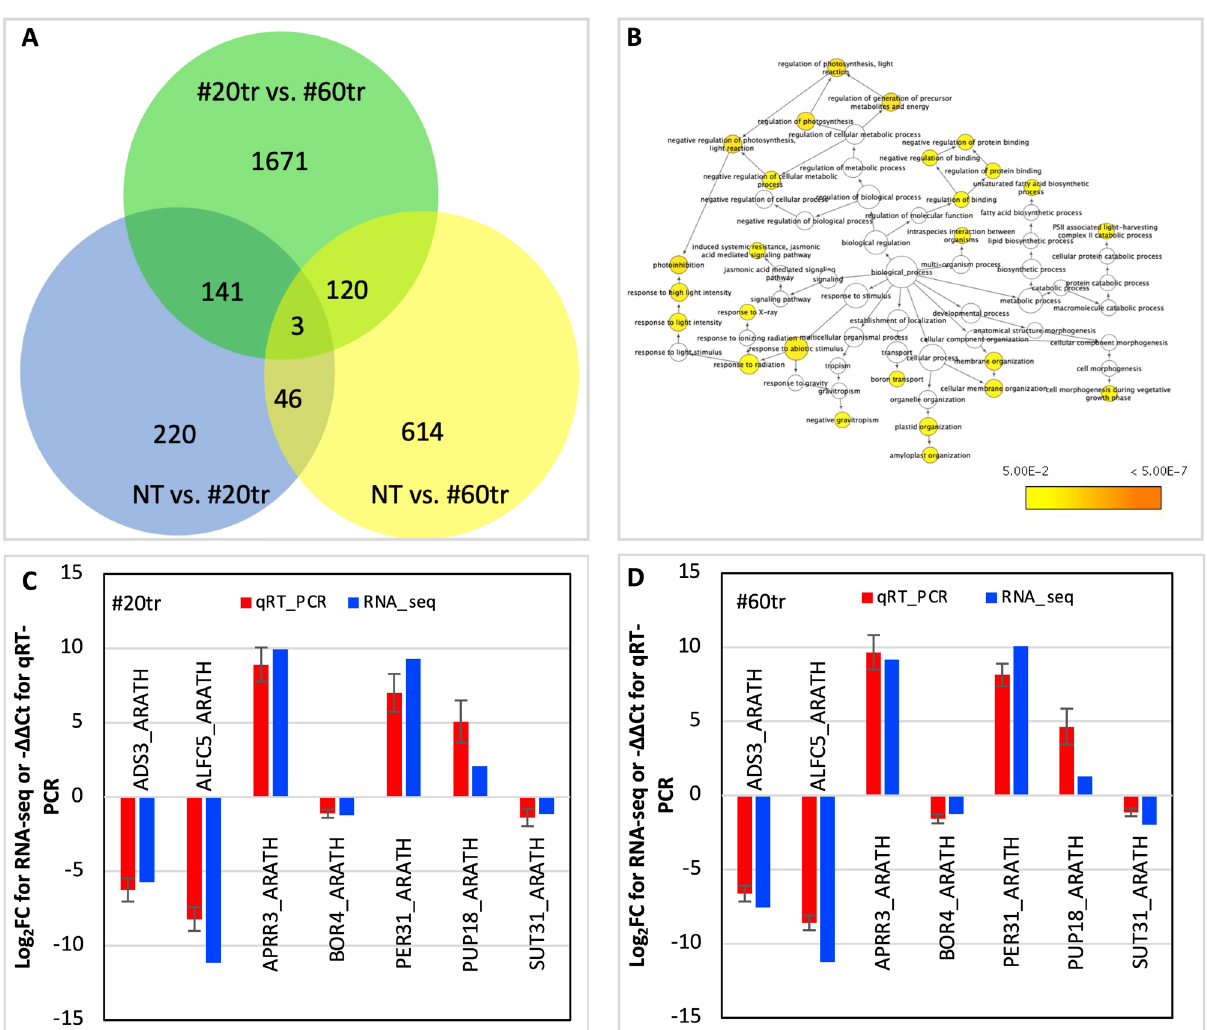
Figure 5. Transcriptome analysis in leaves among T 1 nontransgenic (NT) and two soybean transgenic lines of #20tr and #60tr. ( A ) Venn diagram illustrating overlap of the three transcriptomic comparisons of the annotated, differentially expressed transcripts (DETs). ( B ) Gene networks of differentially expressed genes shared in leaf tissues of transgenic lines of #20tr and #60tr. The ontology file of GO_full in BiNGO was used to identify overrepresented GO terms ( p < 0.05). Bubble size and color indicate the frequency of the GO term and the P-value, respectively. ( C , D ) Comparison of the RT-qPCR analysis result and the RNA-seq data of the selected DETs. − ∆∆Ct is an average of three biological and three technical replicates for each DET. GmActin 1 (SAC1_ARATH) was used to normalize the RT-qPCR